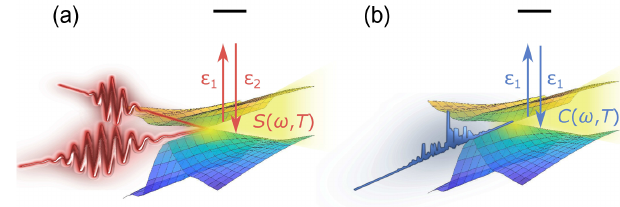
FIG. 1. Off-resonant stimulated x-ray Raman signal (TRUE- CARS) between two molecular potential energy surfaces via an off-resonant core state. (a) CTRUECARS with hybrid broad- ( E 2 ) and narrow-band ( E 1 ) coherent x-ray pulses (red), which requires control over their CEPs, and (b) STRUECARS with one stochastic x-ray FEL pulse ( E 1 , blue) with no phase control.